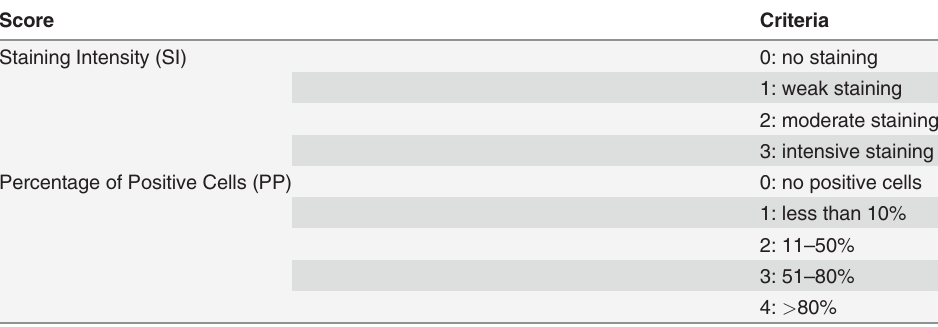
Table 1. Criteria of IHC